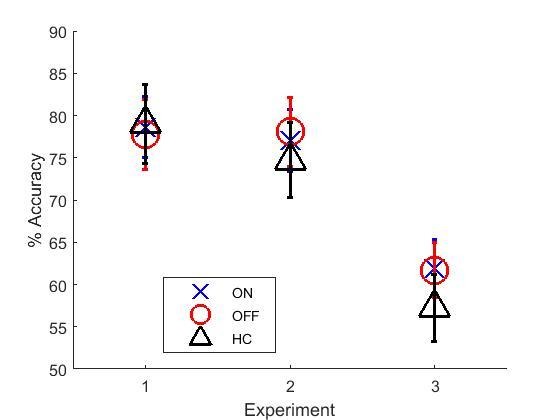
Mean final learning block accuracies across the three experiments.Experiment 3’s final accuracy was significantly lower than experiments 1 and 2’s (p<0.000001). Error bars are SEM. Figure 5—source data 1 shows the summary statistics.DOI:
http://dx.doi.org/10.7554/eLife.26801.01810.7554/eLife.26801.019Figure 5—source data 1.Summary statistics for Figure 5, the mean final learning block accuracies across the three experiments.